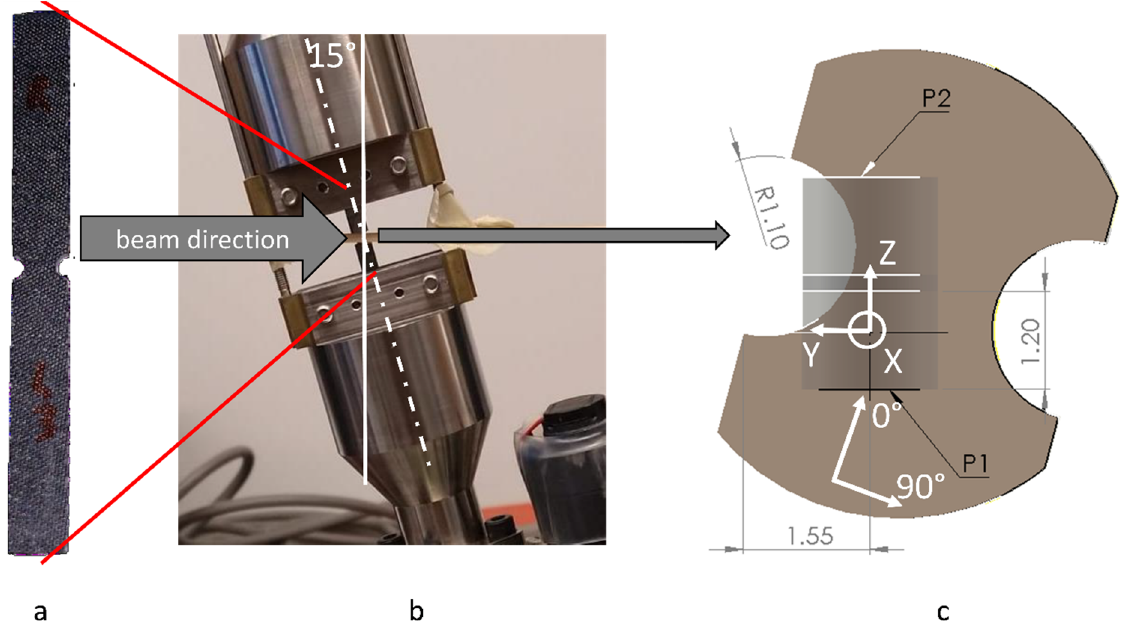
Figure 1. A canted SRCT rig: ( a ) DENT specimen; ( b ) specimen arrangement on a loading stage; ( c ) schematics of the image locations (P1 and P2, overlapped).